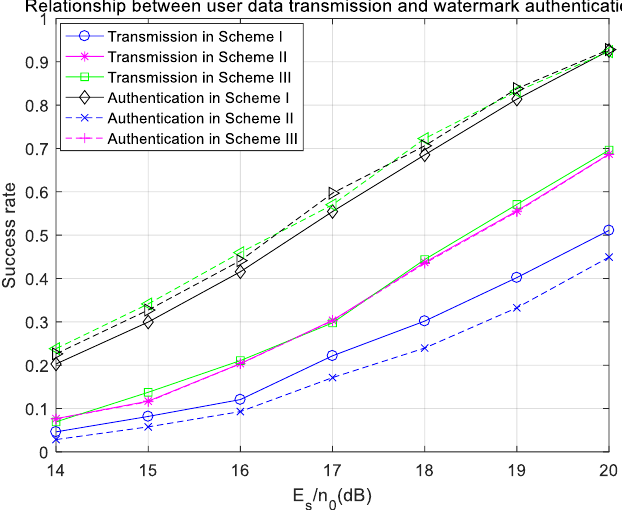
Figure 20. Success rates of user-data transmission and watermark authentication with frequency offset in the fading channel.